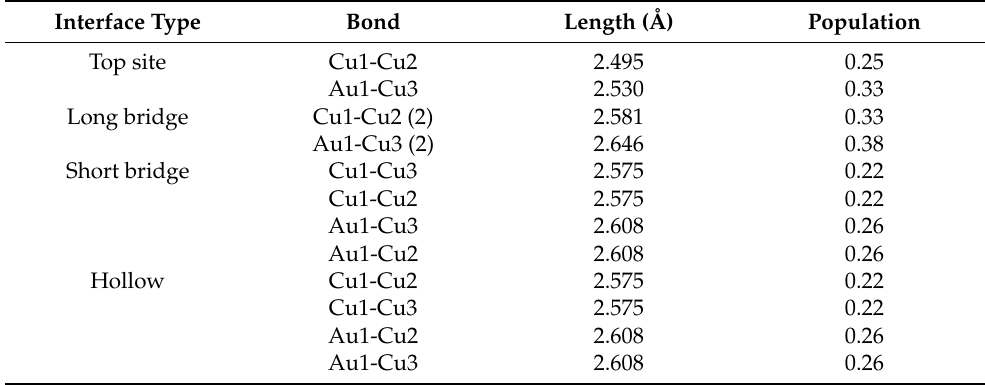
Table 3. Results of Mulliken bond population analysis between nearest-neighbor atoms at four different Cu(200)/AuCu(200)